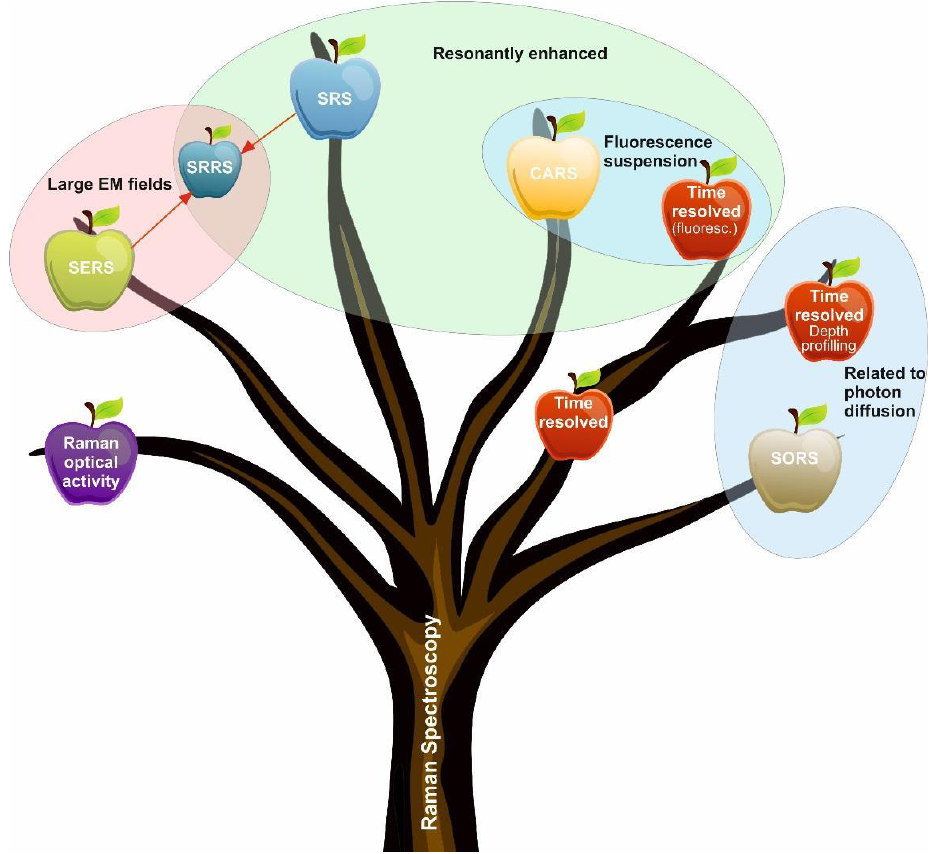
Figure 3. “Family tree” of the RS. The relatively simple RS is the root of the complex surface-enhanced, resonance-enhanced time—and spatially-resolved techniques. Abbreviations: SERS, Surface-enhanced Raman Spectroscopy; CARS, coherent anti-Stokes Raman spectroscopy; RRS, resonance-enhanced Raman scattering; SORS,spatially offset Raman spectroscopy. Modified from Buckley and Ryder [9]. Table 1. The list of modifications of RS with details of the objects and molecules of interest with reference numbers of the papers used in the